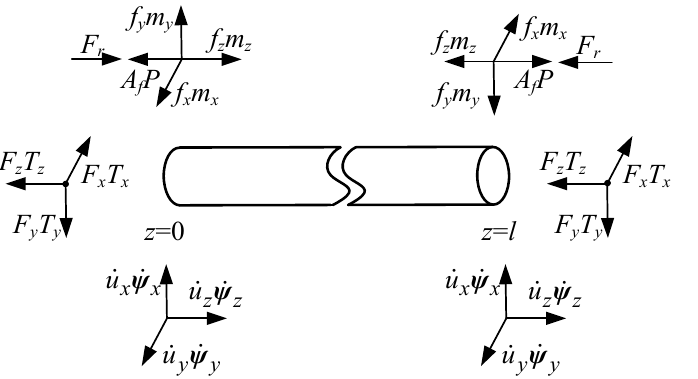
Figure 2. Local coordinate systems of boundary nodes. Reprinted with permission from Ref. [24].